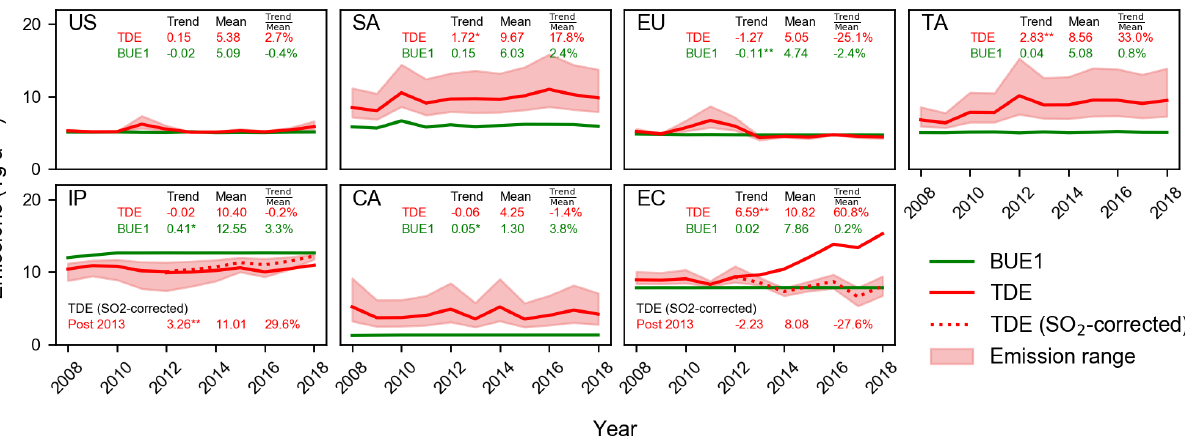
Figure 3. Annual NH 3 emissions for seven selected regions during 2008–2018. The shaded regions represent the upper and lower bounds derived from uncertainty analyses (see Sect. 2.4). Average annual emissions (Tga − 1 ), absolute linear trends (Tga − 1 per decade), and relative trends (% per decade) for 2008–2018 are inset. The asterisk symbols “*” and “**” represent that linear trends are significant at the 95% and 99% confidence levels, respectively. Red dashed lines represent top-down NH 3 emission estimates over IP and EC during 2013–2018, based on Eq. (3) which accounts for observed trends in SO 2 (denoted as “SO 2 -corrected”). Statistics for this estimate are also inset. The prior inventory (BUE1) implemented in our simulation only partially accounts for interannual changes from bottom-up information (i.e., Fig.